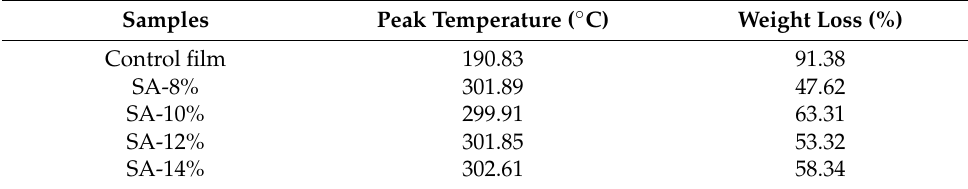
Figure 6. TGA curve of a control film and anthocyanin incorporated in starch films; SA − 8%, SA − 10%, SA − 12%, and SA − 14%. Table 4. Derivative thermogravimetric (DTG) peak temperatures and percent weight